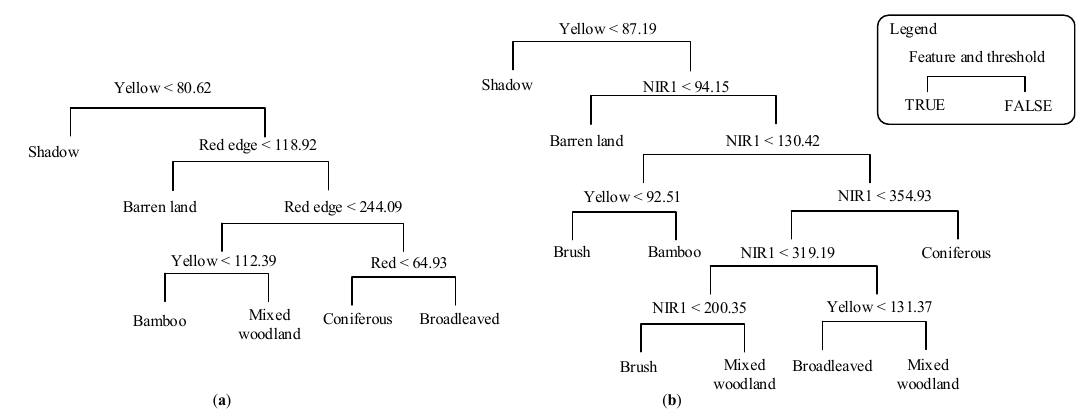
Figure 7. Decision rules of the CART classification based on ( a ) original training data and ( b ) expanded training data.